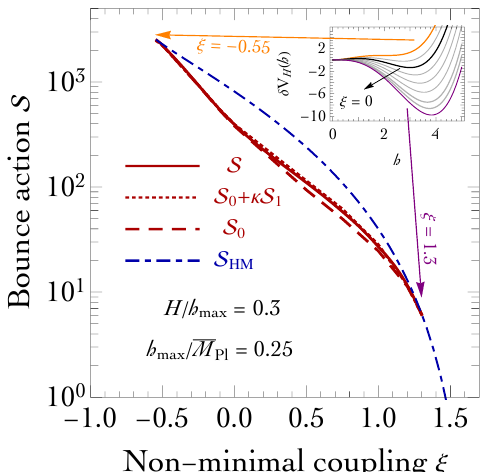
Figure 3 . Coleman and Hawking-Moss bounce actions computed after adding a non-minimal coupling to gravity f = (cid:24)h 2 to the model considered in (cid:12)gure 1. Its main e(cid:11)ect is to modify the e(cid:11)ective potential, so that the true vacuum disappears for negative large (cid:24) , and the potential barrier disappears for positive large (cid:24) . Gravitational corrections to the action are again well approximated by our sub-Planckian